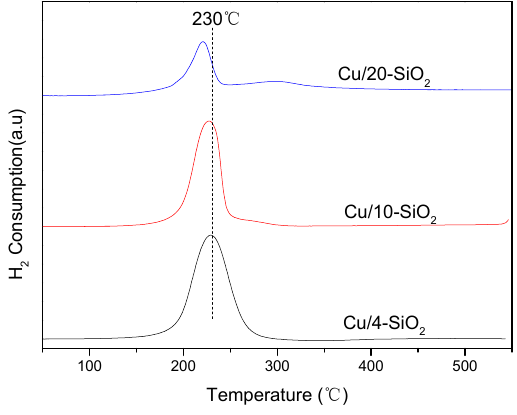
Figure 2. TPR profiles of the calcined Cu/ x -SiO 2 catalysts.